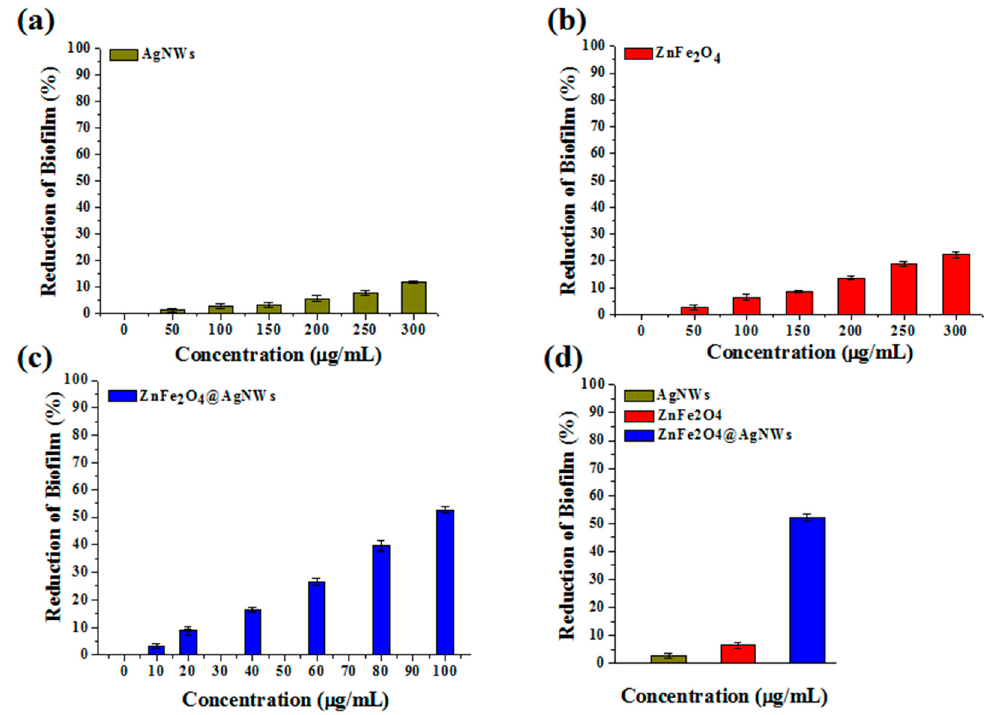
Figure 4. Reduction of biofilm versus nanostructure concentration bar charts obtained from crystal violet staining assays: ( a ) AgNWs, ( b ) ZnFe 2 O 4 NPs, ( c ) ZnFe 2 O 4 @AgNWs hybrid nanostructures, ( d ) comparative reduction of biofilm at a specific concentration of 100 µg/mL. The reduction of biofilm was calculated from the optical density at the wavelength of 595 nm.